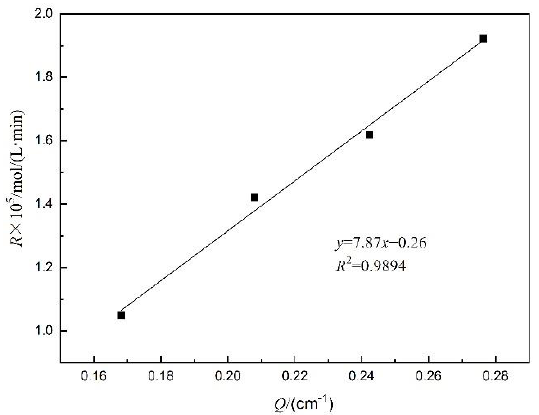
Figure 4. Effect of specific interfacial area on the stripping rate (experimental conditions: HEH/EHP concentration 0.2 mol/L, Ce 4+ concentration in organic phase 0.02 mol/L, HCl concentration in strip- ping agent 6.0 mol/L, c (H 2 O 2 ) (a) : c (Ce) (o) 2:1, temperature 25 °C and stirring speed 300 r/min).